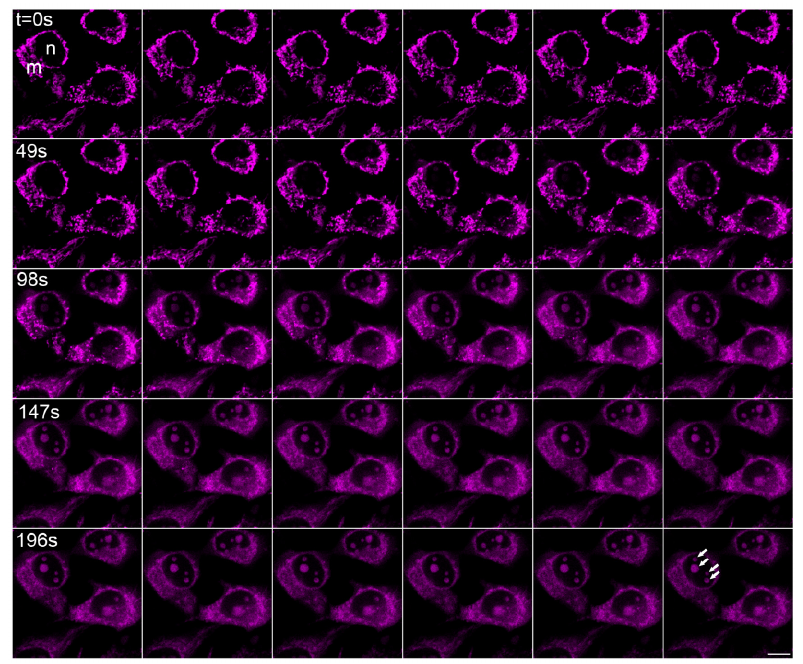
Figure 4. Laser scanning-induced relocalization of chemical C2 from mitochondria to cytoplasm and nucleoli. C2-treated (1 µM) HeLa cells were repeatedly scanned with 633 nm HeNe laser at 50% intensity. Each frame is 7 seconds apart. Elapsed time is shown for every 7 th frame. Mitochondria (m) and nucleus (n) of a cell are shown at the first frame. The four nucleoli of the same cell are indicated with arrows at the last frame. Bar 10